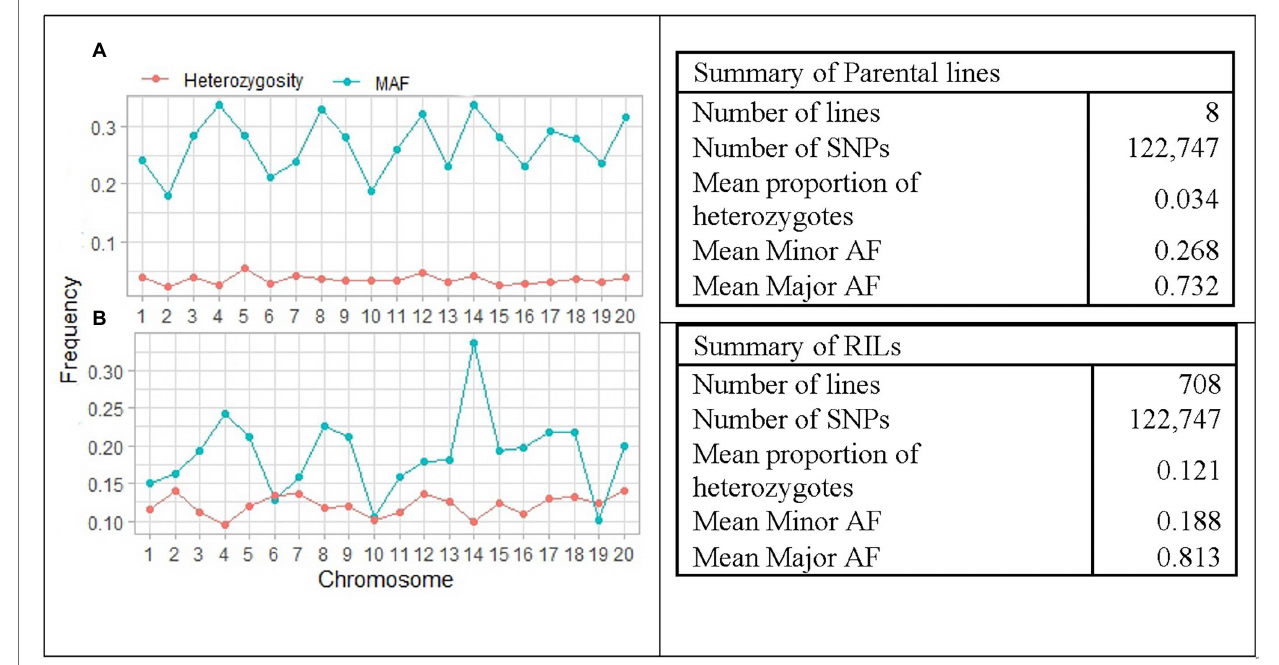
FIGURE 4 | Summary and pattern of genetic features in RILs and parental lines of SoyMAGIC population after filtering out of low-quality SNPs. (A) and (B) display chromosome-wide distribution of minor allele frequency and mean proportion of heterozygosity in the SoyMAGIC parental lines and RILs, respectively. Summary statistic tables describe genome-wide proportion of heterozygosity and frequency of major and minor alleles of SoyMAGIC population in parental lines and RILs.